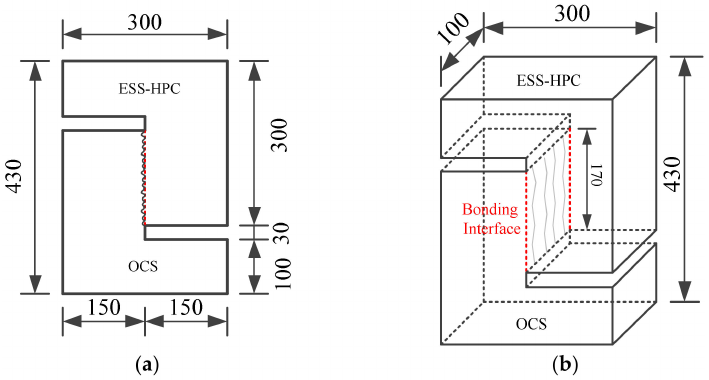
Figure 2. Geometry of direct shear tests (unit: mm). ( a ) Elevation view; ( b ) three-dimensional